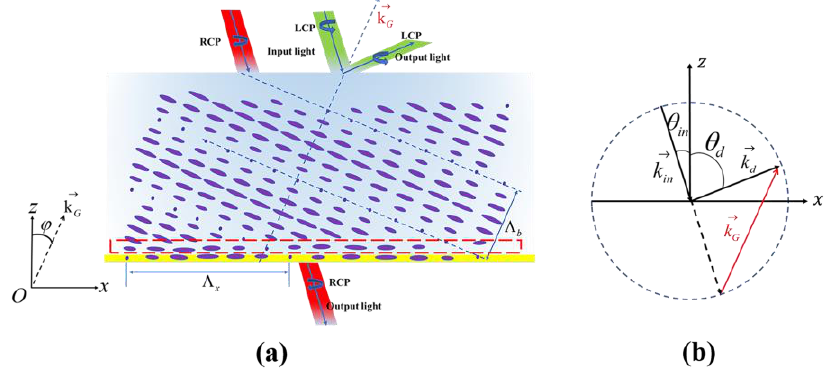
Figure 1. ( a ) Diagrams of the tilted helical structure of PVG. ( b ) Sketch of the relation among input, output, and grating vectors to satisfy the Bragg condition.